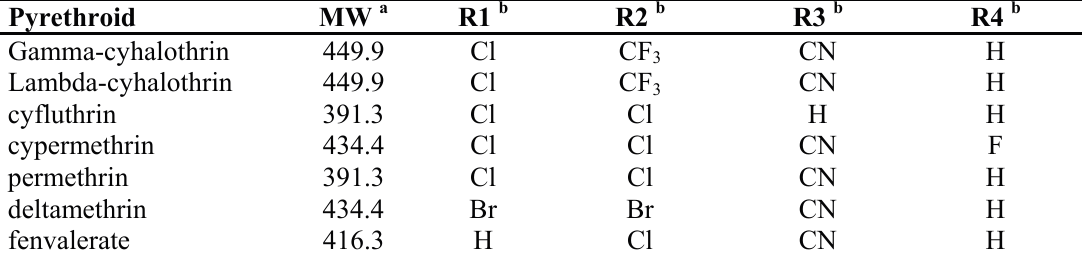
Table 1. Substituted radicals represented in the Figure 1 for each